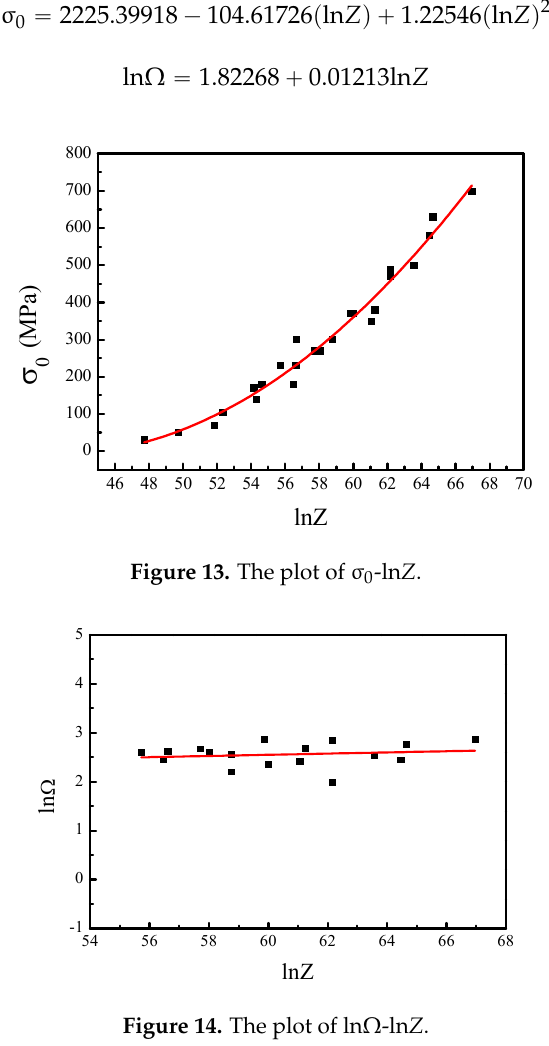
Figure 12. The relationship between σ s and σ p .